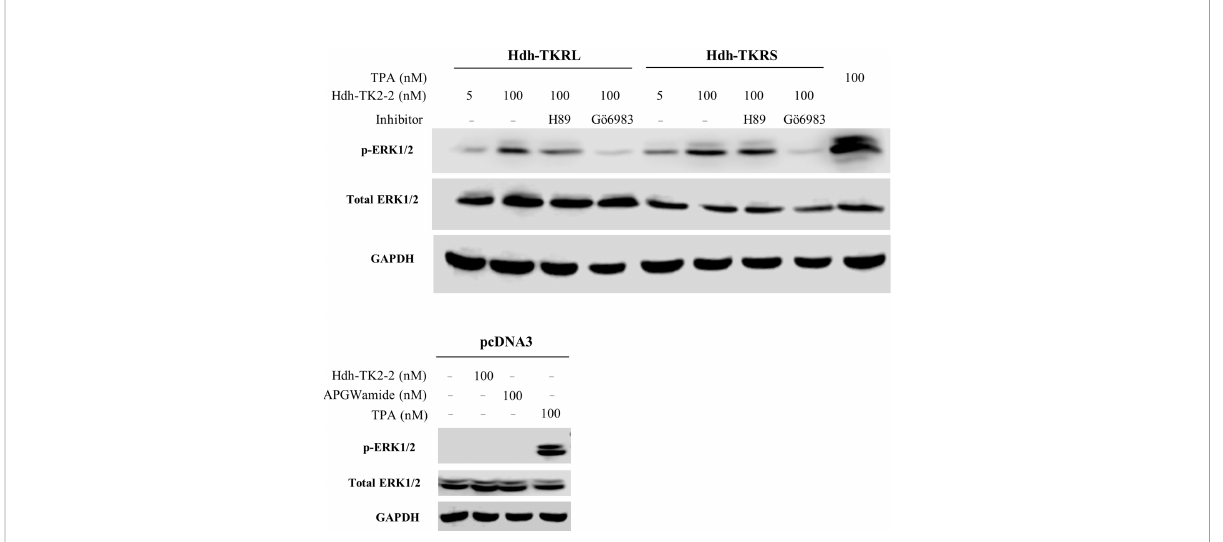
FIGURE 7 Effects of PKA inhibitor H89 and PKC inhibitor Gö6983 on Hdh-TKRL- or Hdh-TKRS-mediated activation of ERK1/2 in HEK293 cells. The cells were pre-incubated with or without inhibitors (10 − 5 M) for 1 h and then stimulated with Hdh-TK2-2 or 12-O-tetradecanoylphorbol-13-acetate (TPA) at the indicated concentrations for 5 min. Phospho-ERK1/2 (p-ERK1/2), total ERK1/2, and GAPDH expression were examined by western blotting of whole-cell lysates. As a control, HEK293 cells transfected with the maternal plasmid, pcDNA3, were also stimulated with Hdh-TK2-2, APGWamide, or TPA at the indicated concentrations, and ERK and GAPDH expression were examined.